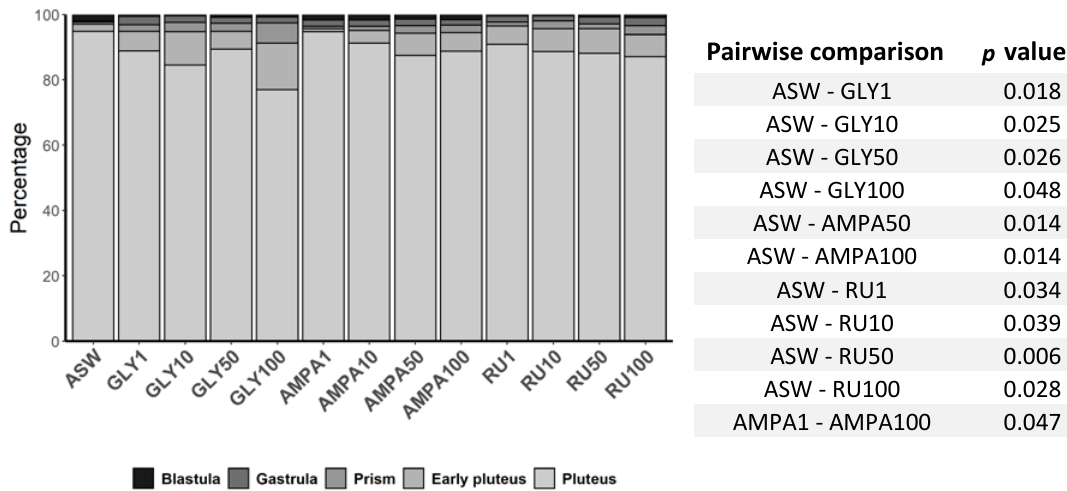
Figure 3. Percentage of developmental stages at 48 hpf in larvae reared in control conditions (ASW) and in four concentrations (1, 10, 50, 100 µ g / L) of three contaminants: glyphosate (GLY), AMPA and Roundup (RU). Statistically significant pairwise comparisons are reported in the table on the